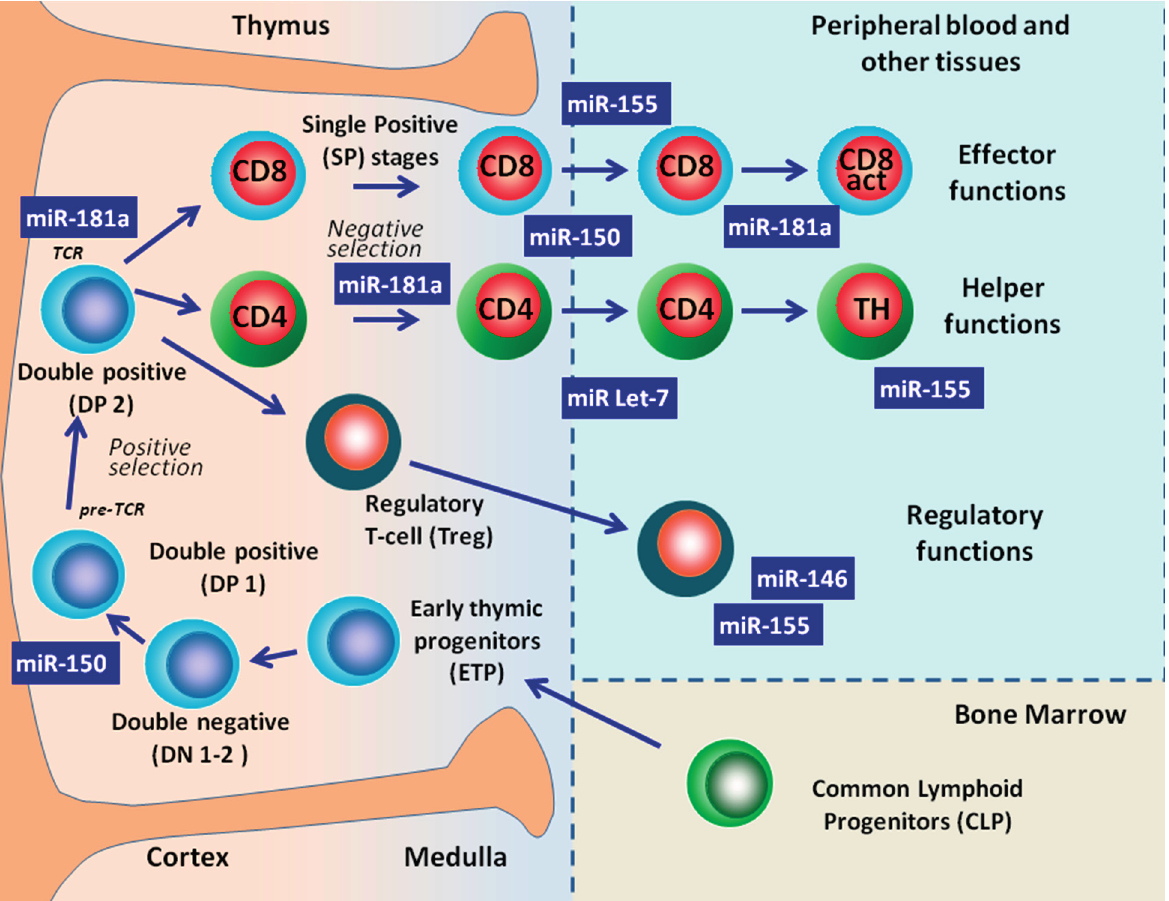
Figure 3. MiRNAs Involved in the regulation of T cell development from common lymphoid progenitor cell to produce functionally mature T